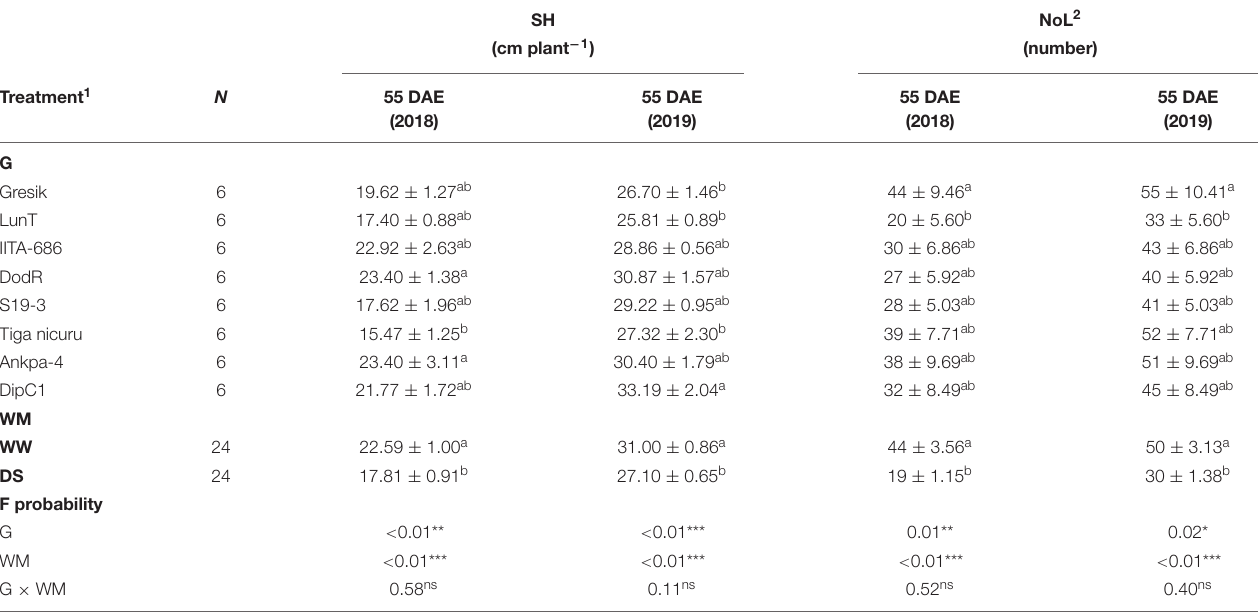
TABLE 1 | Analysis of variance (ANOVA) for shoot height (SH), and number of leaves (NoL) at 55 days after emergence (DAE) of eight bambara groundnut genotypes, grown in soil-filled polyvinyl chloride (PVC) columns in a rainout shelter under well-watered (WW) and drought stress (DS) in two seasons 2018 and 2019. SH NoL 2 (cm plant − 1 )